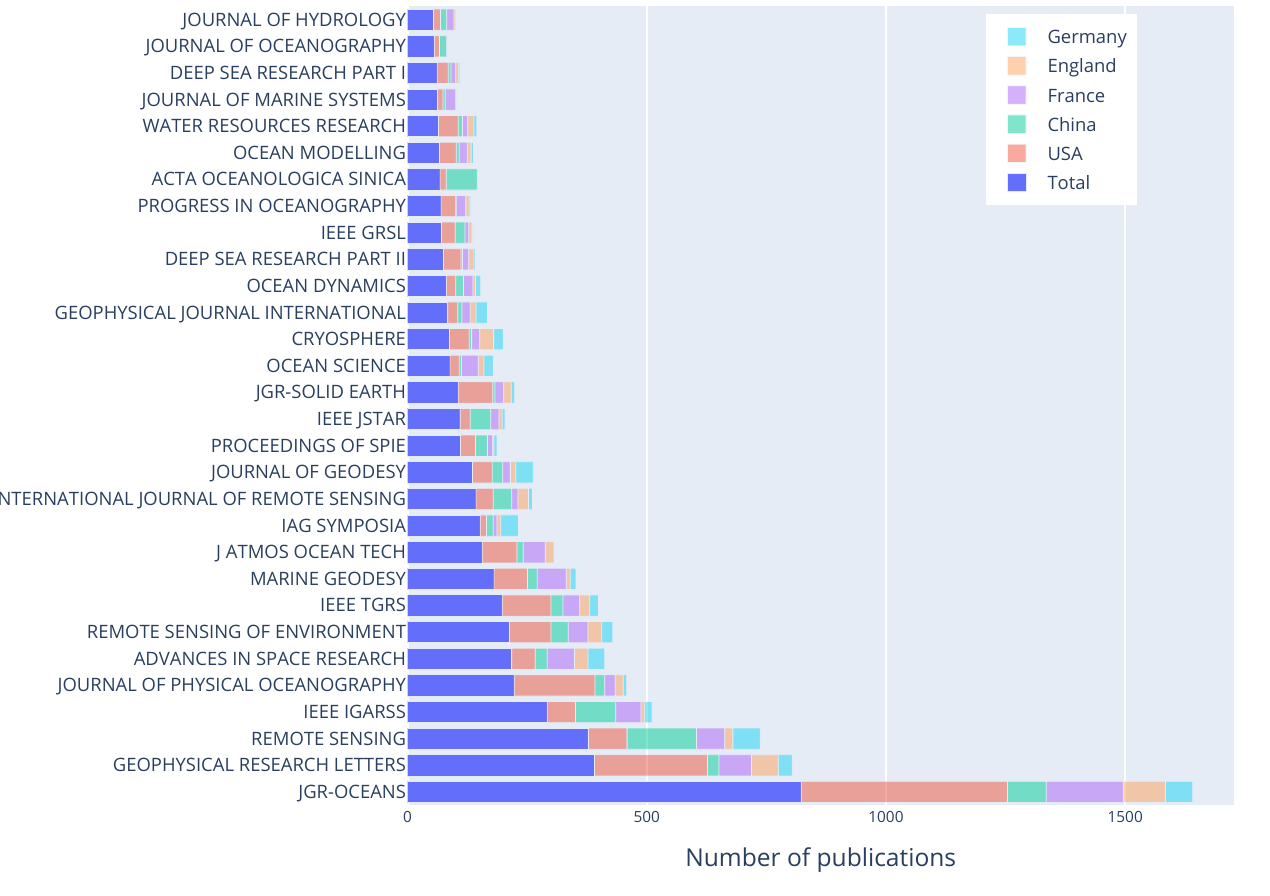
Figure 4. The publication journals of satellite altimetry. The total number of documents for each journal is shown by the blue bars. The following is a stack of documents for the top five countries. Be aware that due to the cooperation, the combined documents of the five countries may be more than the total